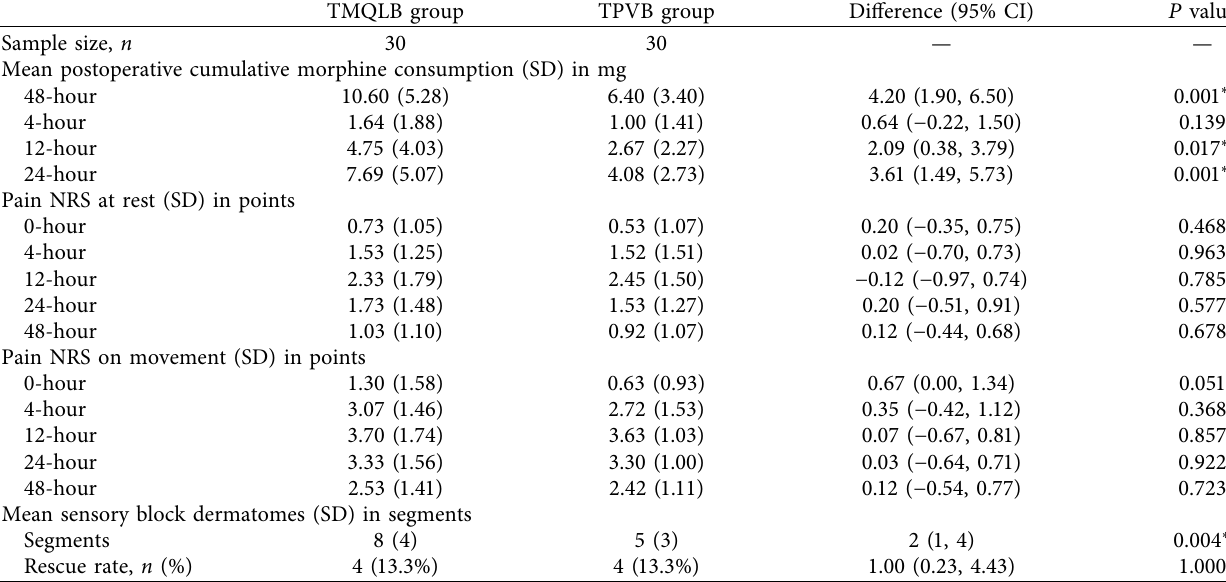
Table 2: Postoperative cumulative morphine consumption and pain NRS of transmuscular quadratus lumborum block and paravertebral block at diferent time points.